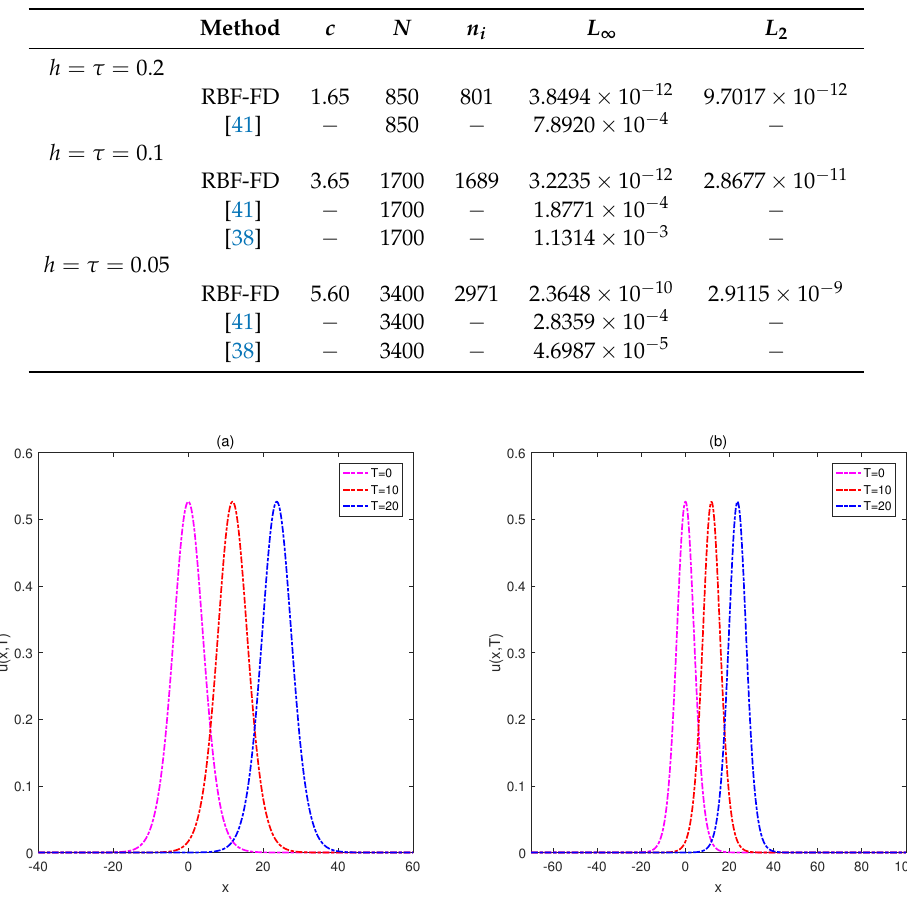
Figure 3. Motion of the single solitary wave with τ = h = 0.05, at various times over the intervals: x ∈ [ − 40,60 ] ( a ) and x ∈ [ − 70,100 ] ( b ) for Example